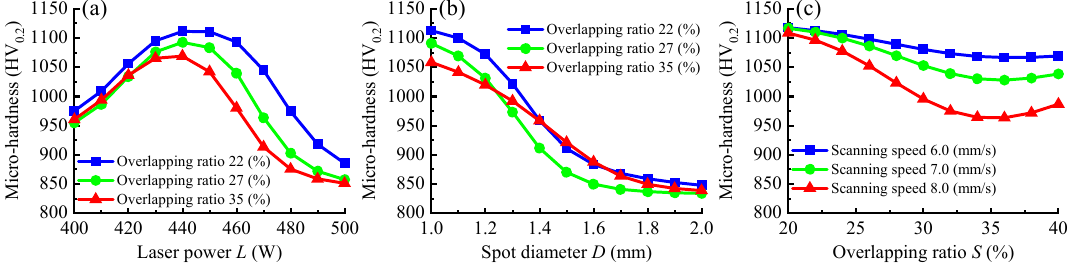
Figure 14. Trend plot of coating micro-hardness: ( a ) laser power; ( b ) spot diameter; ( c ) overlapping ratio.